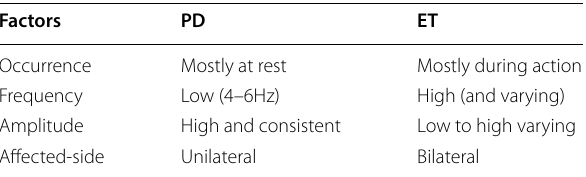
Table 1 Distinction between Parkinson’s tremor